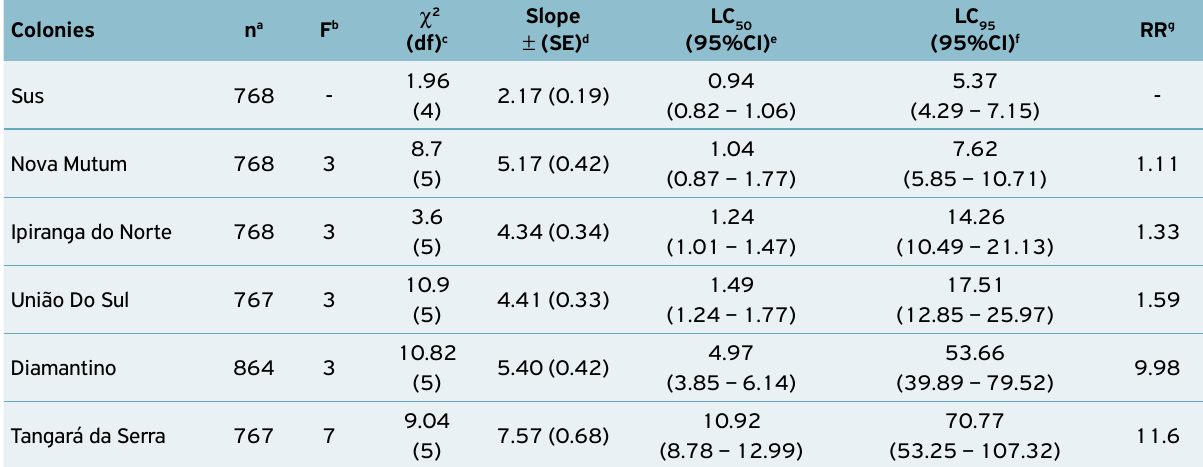
Table 4. Susceptibility of C. includens populations to lufenuron. Colonies